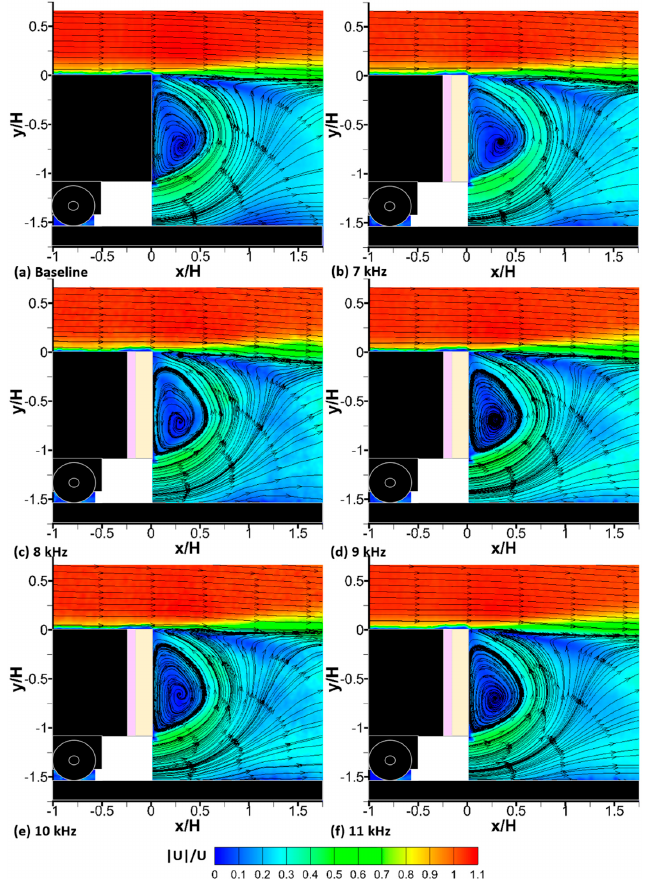
Figure 8. Streamtraces and normalised velocity magnitude contour downstream of the trailer rear end at various plasma actuation frequencies. ( a ) Baseline, ( b ) 7 kHz, ( c ) 8 kHz, ( d ) 9 kHz, ( e ) 10 kHz, and ( f ) 11